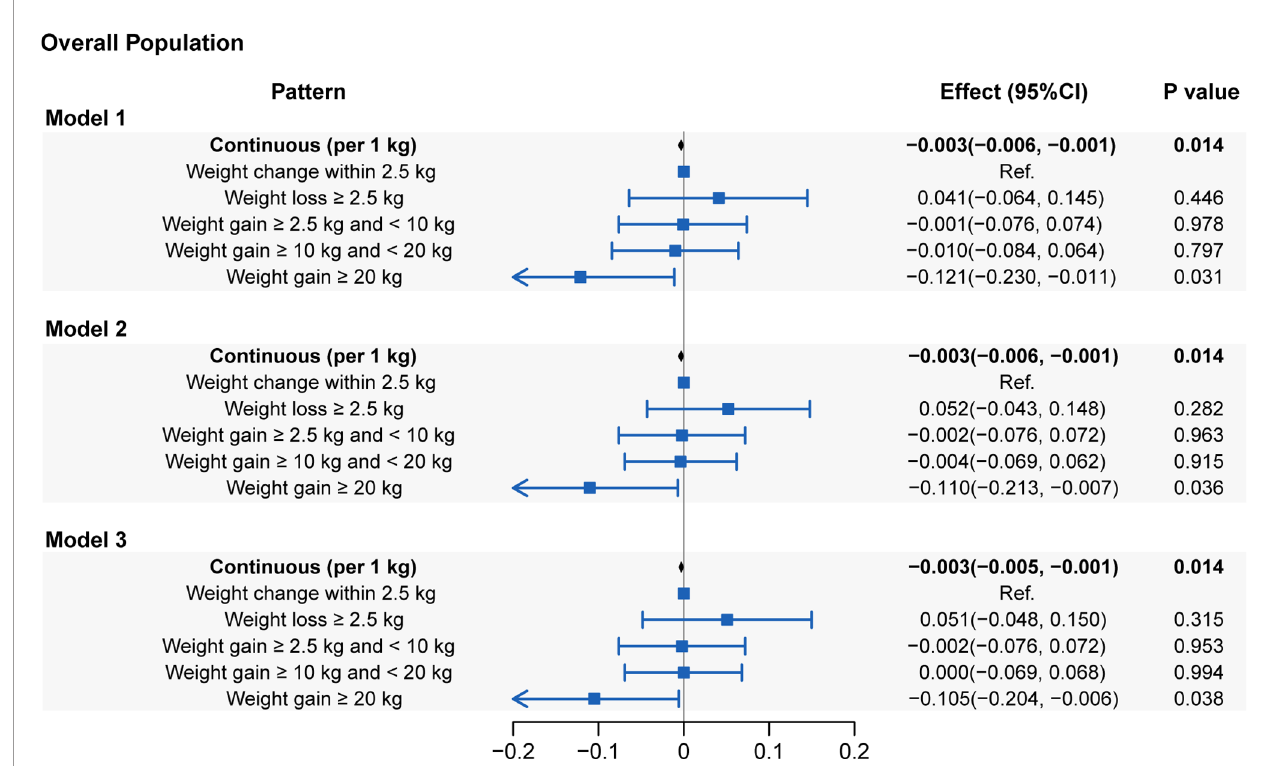
FIGURE 3 | Associations of leucocyte telomere length with absolute weight change (presenting as continuous and categorical forms). Model 1 : adjusted for age, sex and race/ethnicity. Model 2 : adjusted for covariates in Model 1 plus educational level, family PIR, physical activity, energy intake, alcohol use and smoking status. Model 3 : adjusted for covariates in Model 2 plus self-reported health, family history of diabetes, family history of angina, cardiovascular disease, diabetes and